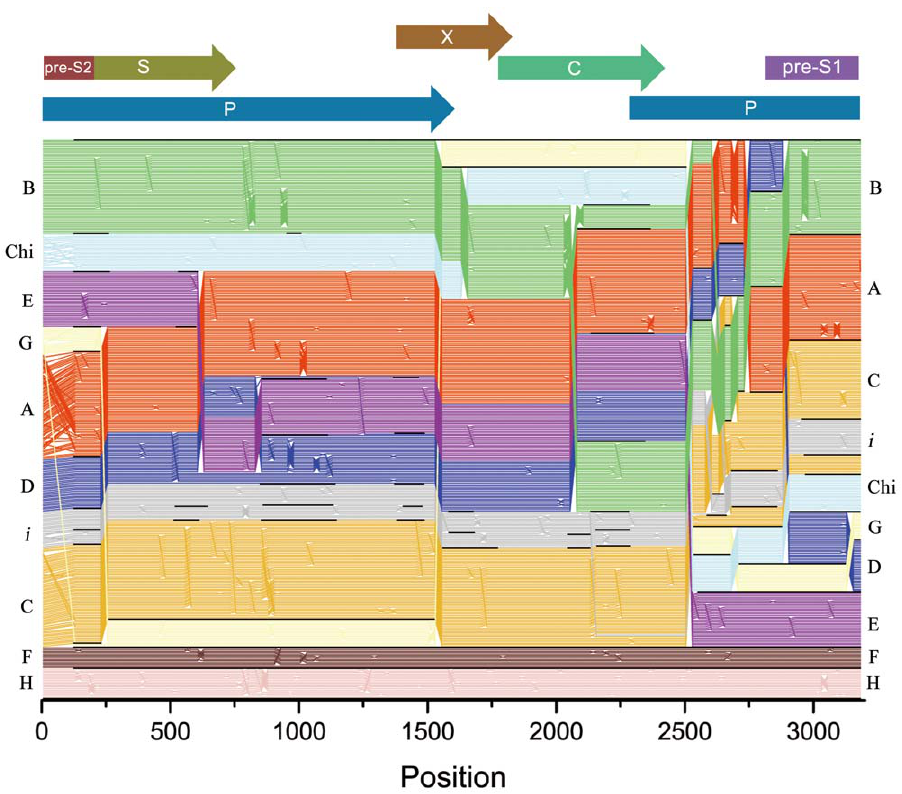
Figure 4. TreeOrder Scan of nonrecombinant HBV sequences. It shows positions of individual sequences (y axis) in phylogenetic trees generated from sequential 250-base sequence fragments, incrementing by 25 bases (midpoints indicated in x axis). Changes in sequence orders resulting from changes in phylogeny at the 70% bootstrap level are shown. Sequences are color coded by genotype, as indicated by labels in left margins: genotype A, red; B, green; C, yellow; D, blue; E, purple; F, pink; G, pale yellow; H, brown; chimpanzee (Ch), light blue; woolly monkey (outgroup on line 1), black. The boundaries of sequence groupings with 70% or greater bootstrap support are indicated with black horizontal lines; for clarity, only clades between genotypes (except for group I) and with six or more members were demarcated. For comparison, the TreeOrder Scan was aligned with a scale genome diagram of HBV (upper panel).